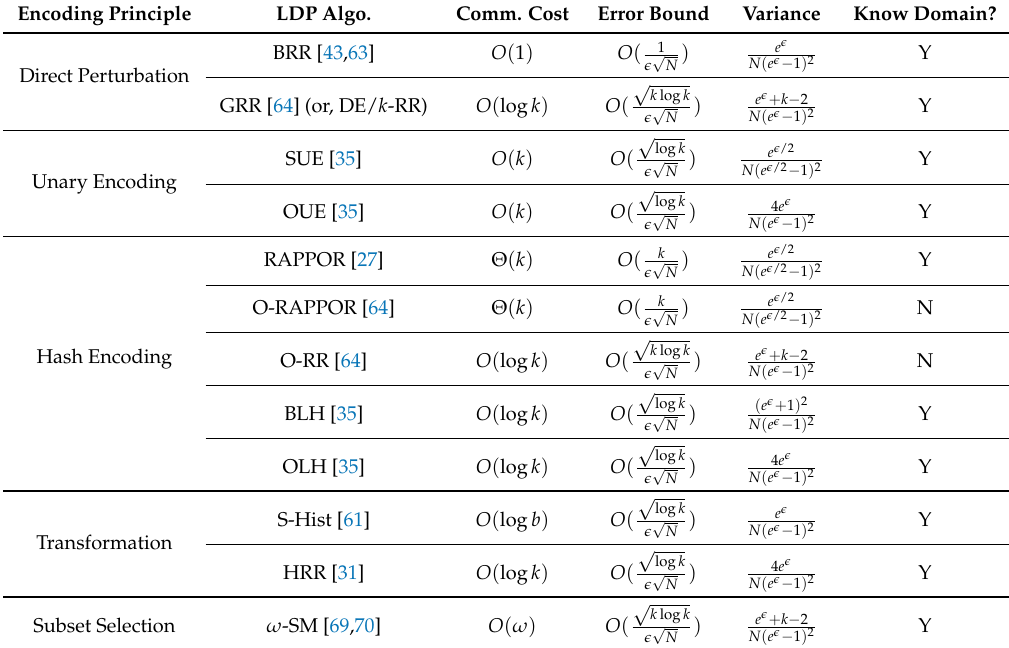
Table 4. Comparisons of general LDP protocols for frequency